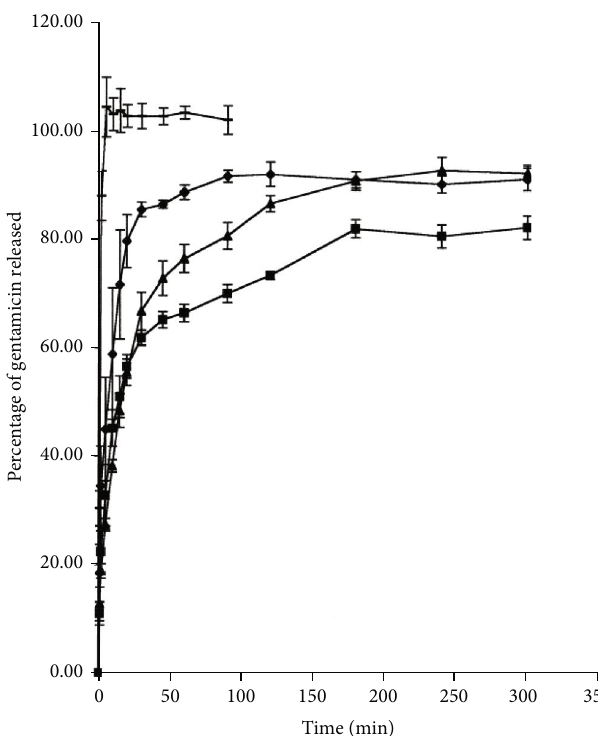
Figure 28: Release pro fi les of gentamicin sulphate from microsphere formulations: ( ⯁ ) CH; ( ■ ) HA/CH; ( ▲ ) HA; ( — ) gentamicin/lactose; mean ± S : D : ( n = 6 ) [107].